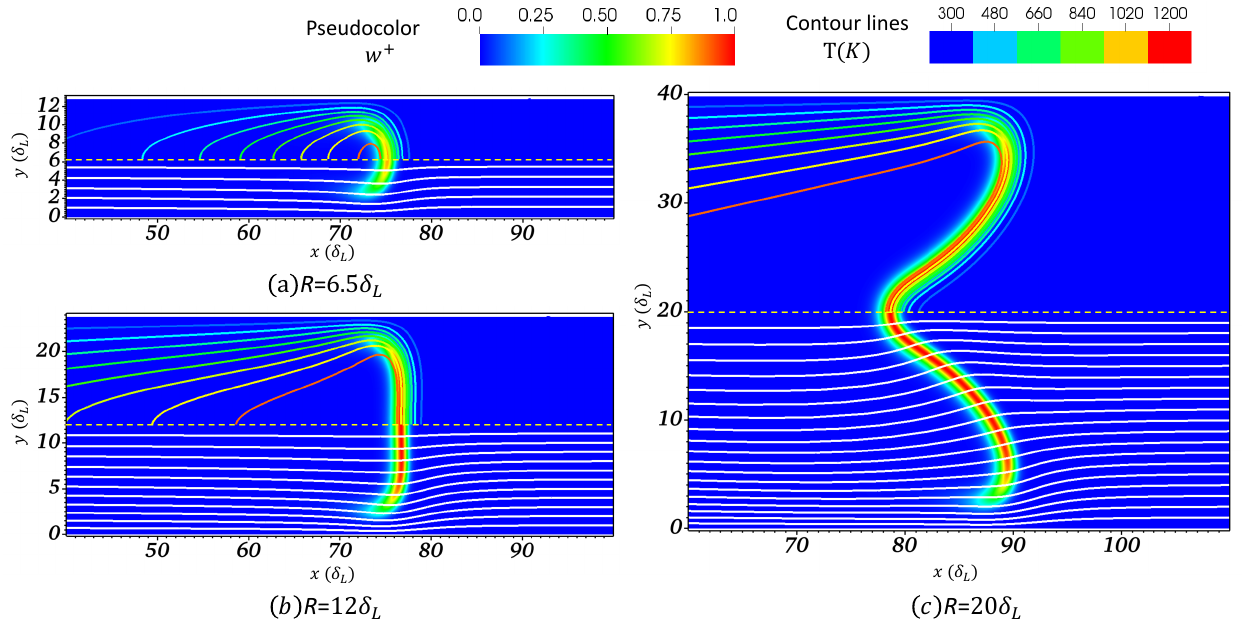
Figure 6. Comparison of the flame shapes for different channel widths at the critical condition. Flame shapes are illustrated by the reaction rate field and the temperature contour lines. Streamlines are shown in white. Channel half-width R = 6.5,12,20 δ L , θ = 4, isothermal